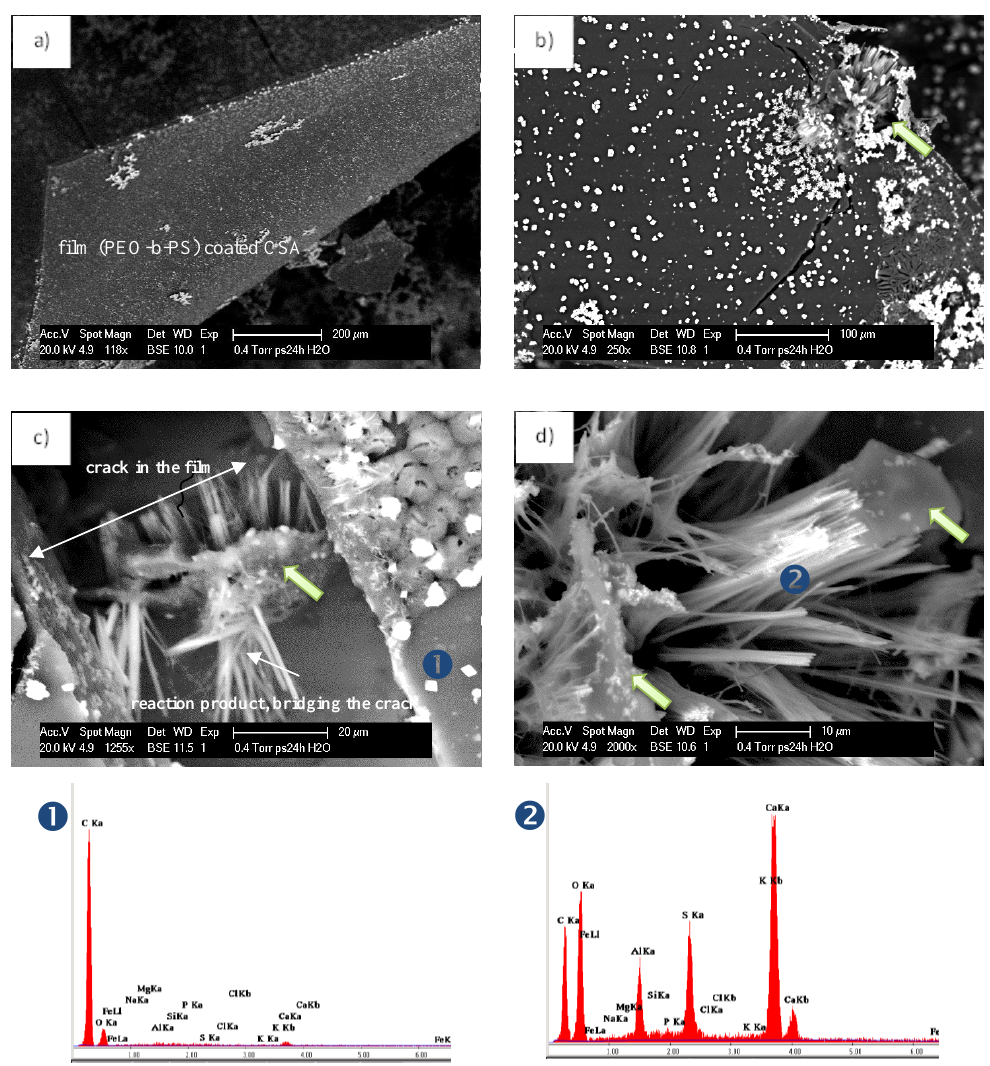
Figure 5. PEO-b-PS + CSA composite after 24 h treatment in aqueous medium ( a , b ); higher magnification of the reacted CSA, bridging micro-cracks ( c ) and a remaining PEO-b-PS on the hydration product ( d ). The EDX patterns ( bottom of figure ) present the result from local spot analysis, corresponding to the indicated locations in c) and